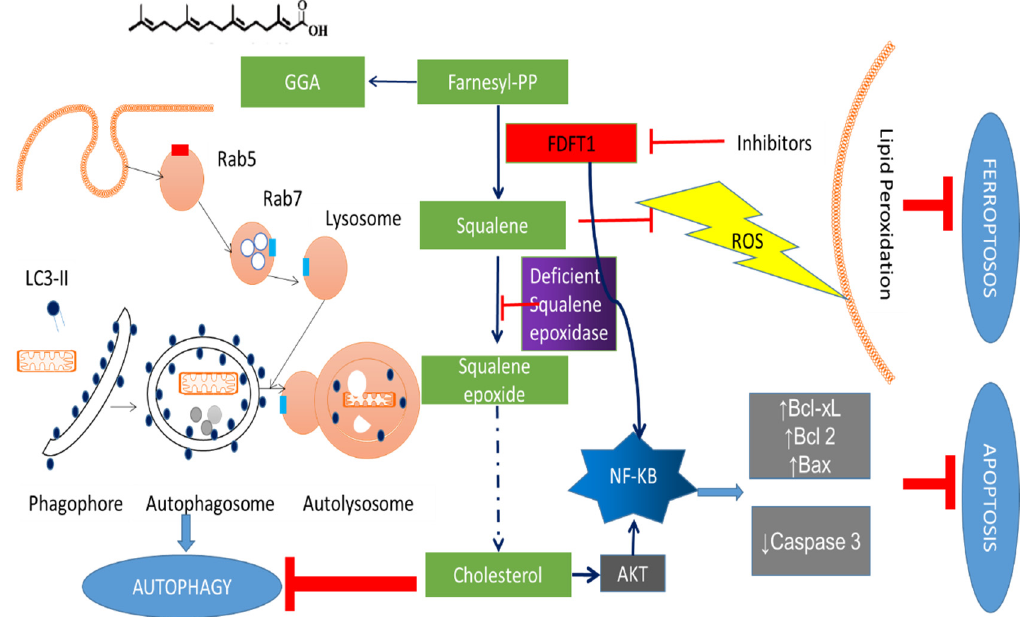
Figure 4. The association between FDFT1 and cell death. FDFT1 is directly or indirectly associated with apoptotic signals. FDFT1 could directly activate NF-KB pathways or activate AKT through cholesterol synthesis. Activated NF-KB increases anti-apoptotic proteins, such as Bcl-xL, Bcl-2, and Bax and decreases pro-apoptotic proteins such as caspase-3, thereby blocking apoptosis signalling. In cancer cells with deficient squalene epoxidase, high expression of FDFT1 increased intracellular squalene levels, which protects the cell membrane from lipid peroxidation by ROS and further prevents the cell from entering the ferroptosis pathway. Furthermore, FDFT1 inhibition upregulates endogenous geranylgeranoic acid (GGA) content, which has been demonstrated to cause incomplete autophagy, and a decrease in cholesterol level also activates autophagy.